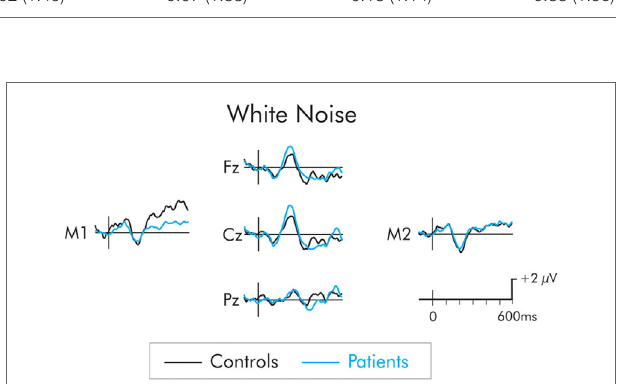
FigUre 4 | P3a following presentation of the white noise for patients (blue) and controls (black). Although, the P3a was larger in the patient group, the between group difference was not significant.